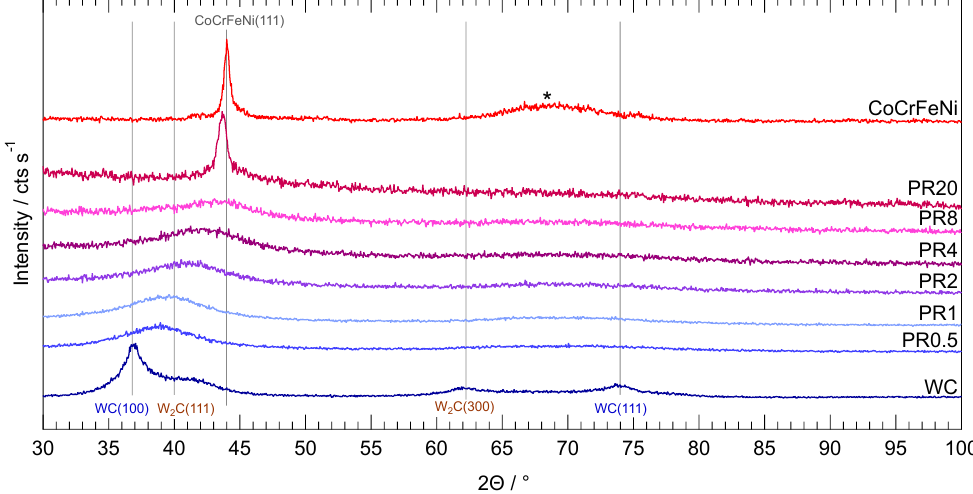
Figure 2. X-ray diffraction patterns of the WC-CoCrFeNi mixed thin films and pure WC and CoCr- FeNi for comparison. Assigned signals are labelled according to the Crystallographic Open Database (see, e.g., [22]). The asterisk marks the residual of the suppressed Si(400) signal from the